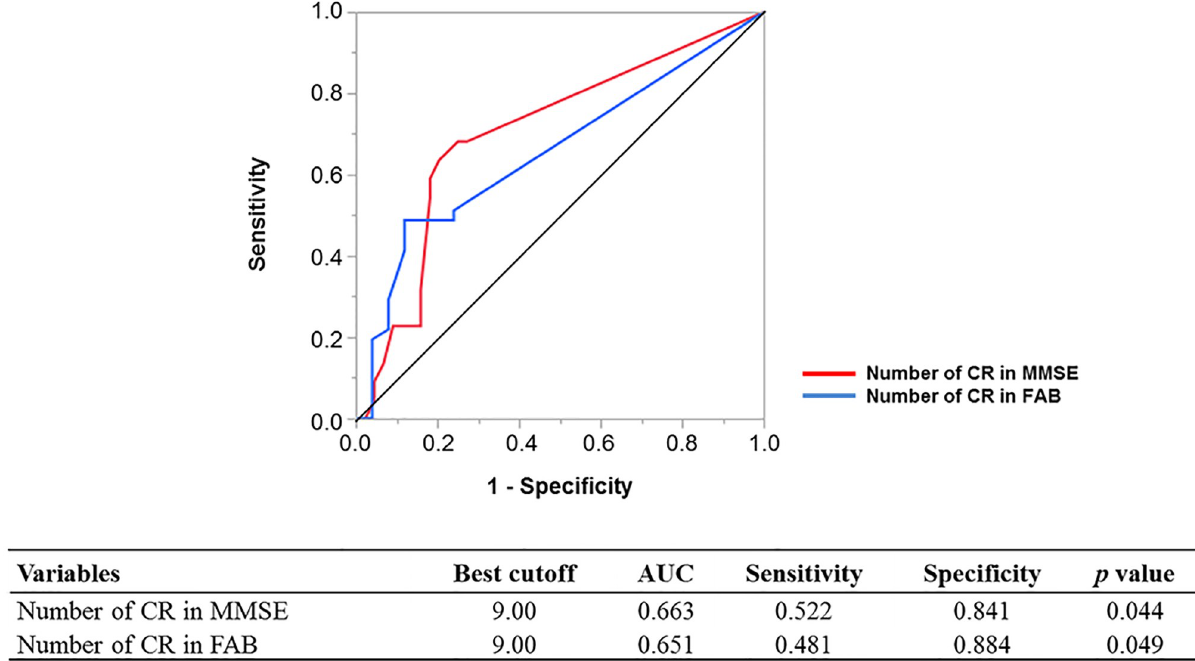
Fig 5. Receiver-operating characteristic curve to detect cognitive improvement. AUC, area under curve; CR, cardiac rehabilitation; FAB, Frontal Assessment Battery; MMSE, Mini-mental State Examination.